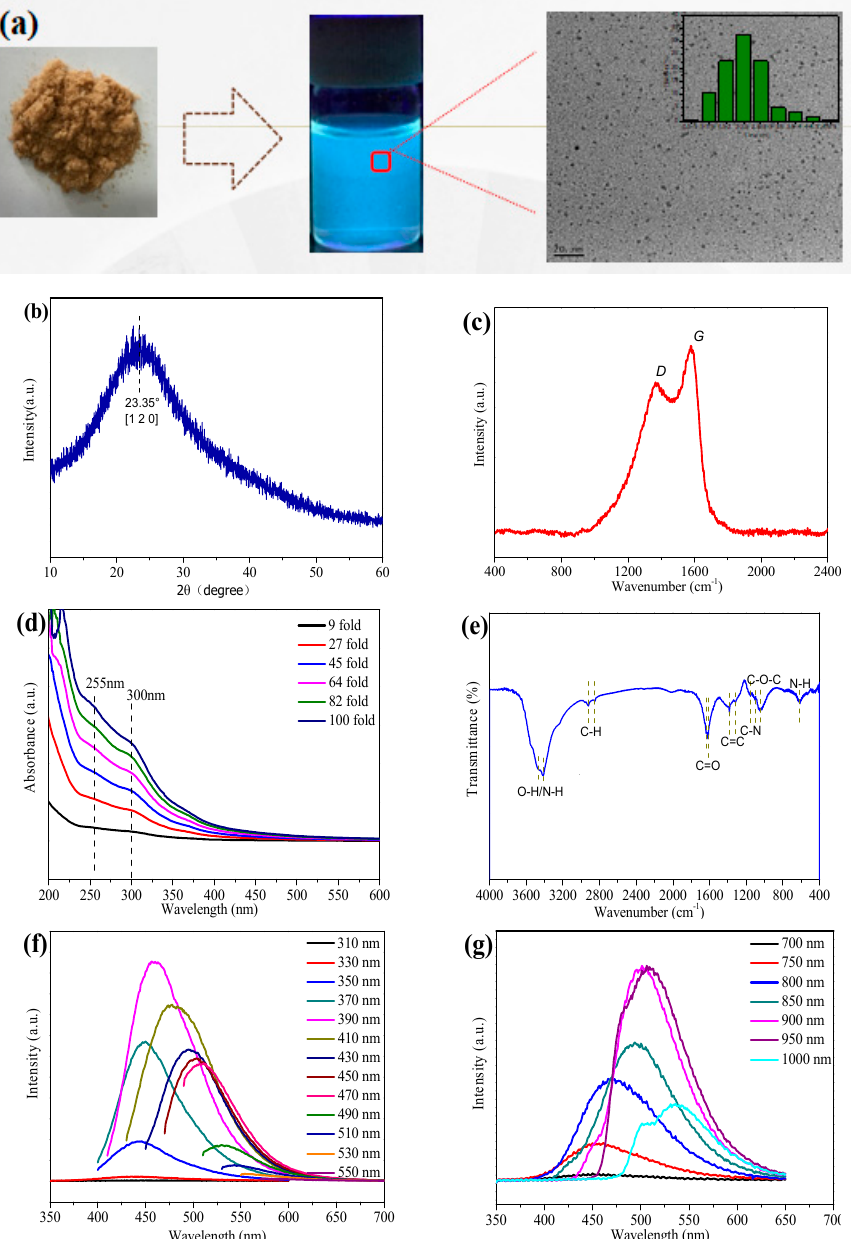
Figure 3. ( a ) Quantitative dispersion from solid-state N-CQDs to N-CQDs solution; ( b ) X-ray diffraction pattern of N-CQDs; ( c ) Raman spectrum of N-CQDs; ( d ) UV-vis absorption spectra of N-CQDs; ( e ) Fourier Transform Infrared (FTIR) spectrum of N-CQDs; ( f ) photoluminescence (PL) spectra of the N-CQDs; ( g ) Up-convention fluorescence spectra of N-CQDs; The heating time for N-CQDs is 2 h.